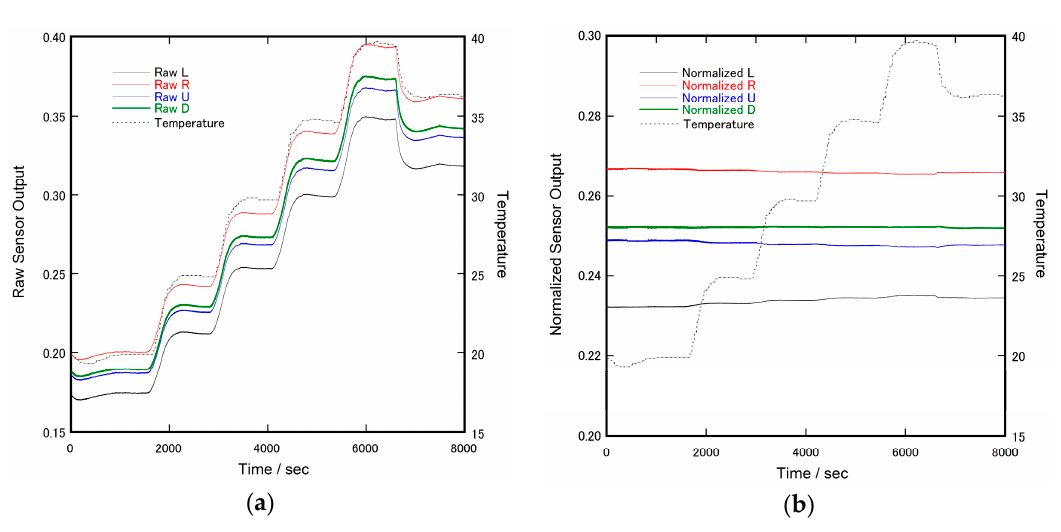
Figure 7. Time courses of the sensor output and the chamber temperature of the thermo-hygrostat: ( a ) Raw sensor output. The vertical scale of raw data is equivalent to the signal level of ADC (full range is 0.0–3.3 V); and ( b ) Normalized sensor output (no unit).